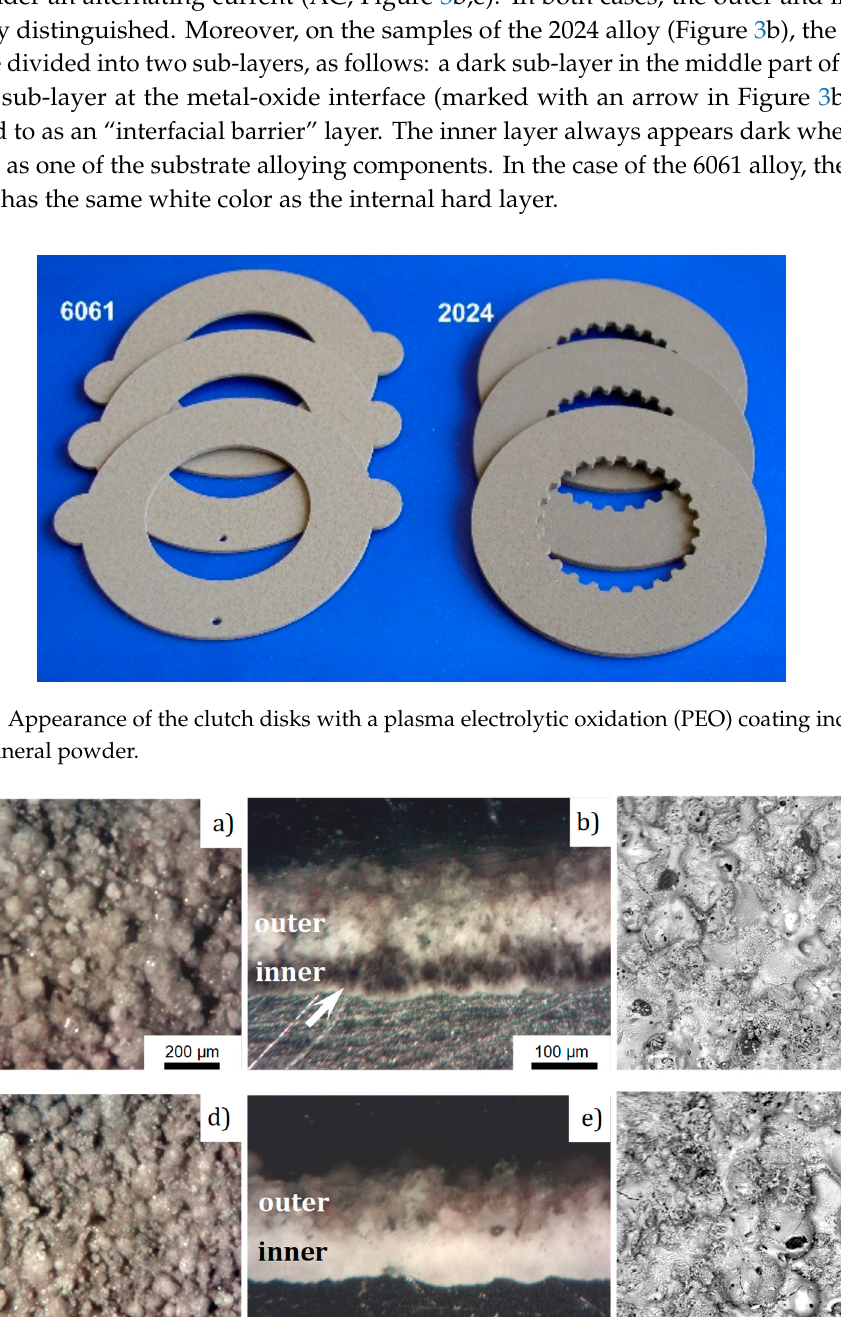
Figure 3. Optical micrographs of surfaces ( a , d ) and cross sections ( b , e ); SEM BSE images ( c , f ) of the PEO coatings obtained on the 2024 ( a – c ) and 6061 ( d – f ) aluminium alloys. The arrow indicates the interfacial layer.